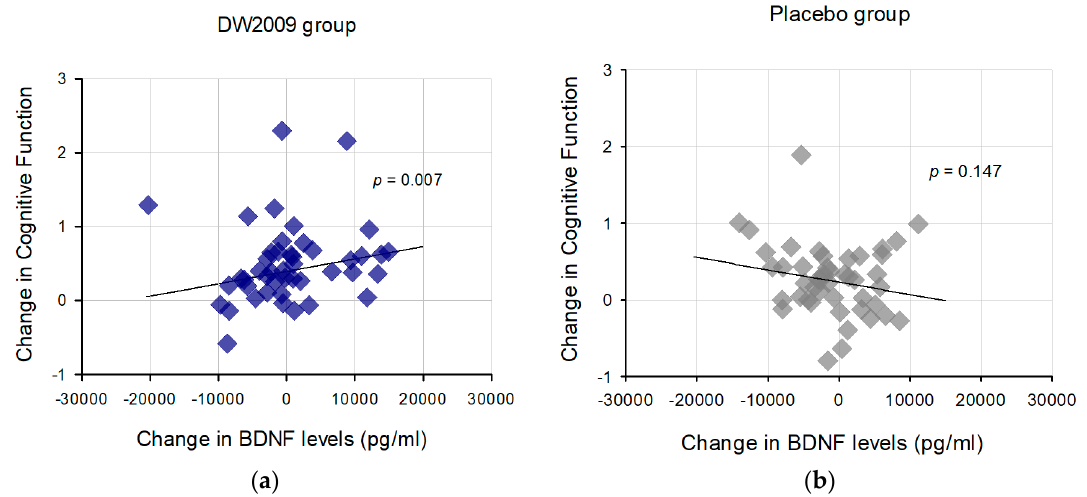
Figure 3. Association between change in brain-derived neurotrophic factor (BDNF) levels and combined cognitive function in ( a ) DW2009 treatment group and ( b ) placebo group. Composite z scores for the combined cognitive function were calculated by averaging z scores of the measured cognitive domains (attention, working memory, and verbal memory).